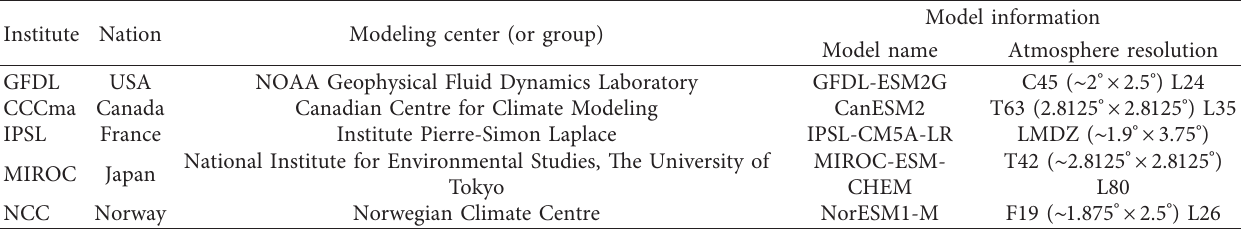
Table 3: Information of the five CMIP5 global climate models.